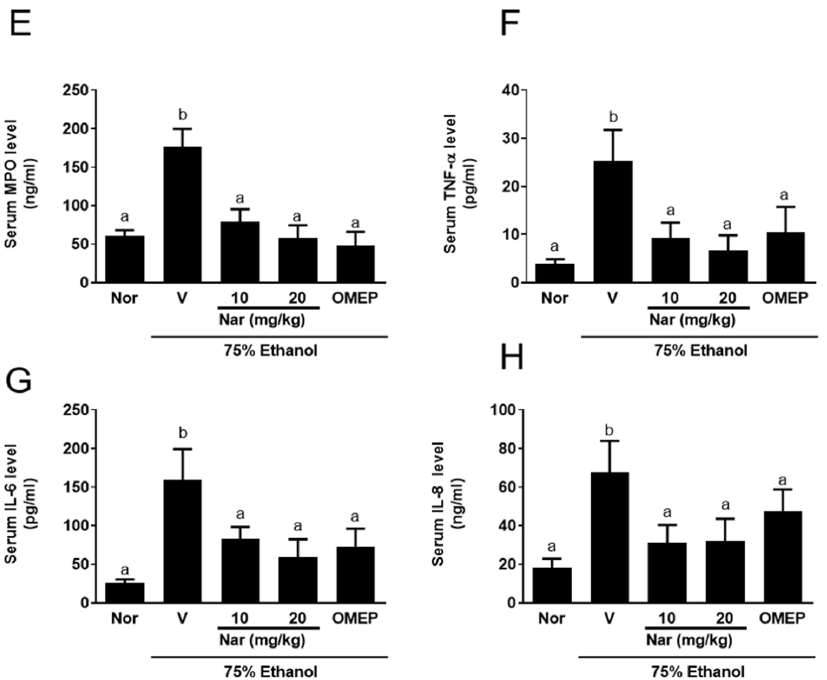
Figure 5. Effect of naringenin on myeloperoxidase (MPO) activity and cytokine levels (TNF- α , IL-6, and IL-8) in the stomach homogenate ( A – D ) and in serum ( E – H ). The vehicle (10% dimethyl sulfoxide (DMSO) and 90% glyceryl trioctanoate), naringenin (Nar, 10 and 20 mg/kg) and omeprazole (OMEP, 20 mg/kg; used as a positive control) were given orally for a period of 3 days. After fasting for 12 h prior to the experiment, mice were fed orally with ethanol (0.5 mL/100 g body weight) to induce the acute ulcer. After 4 h, mice were sacrificed. The data obtained from individual animal samples per group were averaged ( n = 6); values represent mean ± standard deviation (SD). Statistical comparison was analyzed by a one-way ANOVA followed by Tukey’s multiple comparison tests. Bars not sharing a common letter represent a statistically significant difference from each other ( p < 0.05). In the normal control group, the mice only received vehicle (Normal). Nor, normal; V, vehicle.